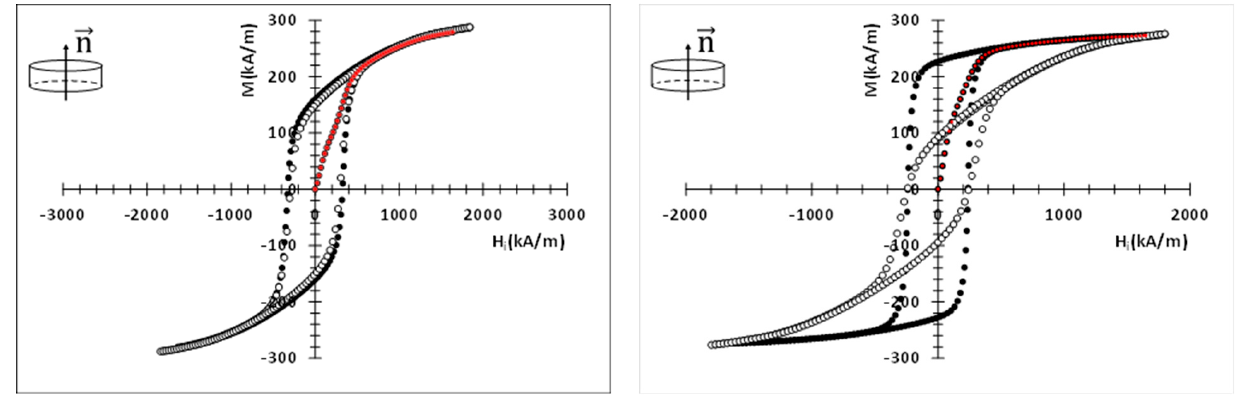
Figure 11. Hysteresis cycles measured for samples BaM-0 ( left ) and BaM-100 ( right ). Black symbols: → → H // n , open symbols: H ⊥ n . The dashed lines in red are the first magnetization